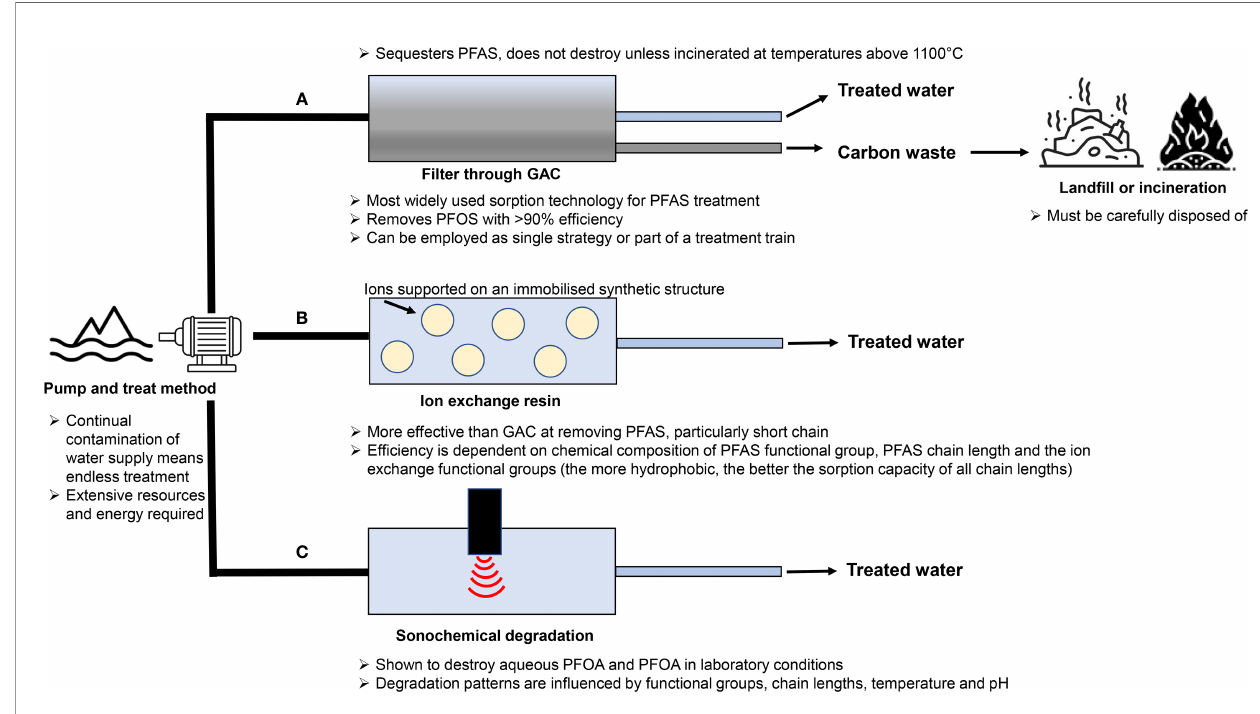
FIGURE 4 | Schematic diagram of three possible treatment mechanisms for PFAS contaminated water. (A) Carbon-rich sorbents such as granular activated carbon (GAC) have a long history of being utilised to remove a variety of organic contaminants from water and as such are by far the best studied and most widely used sorption technology for treating PFAS contaminated water sources (208). Granular activated carbon has been shown to reliably remove PFOS with over 90% ef fi ciency (59, 210) and is thus now the reference point for comparison of all new PFAS water sorption technologies. This technology can be employed to treat water before it reaches consumers, either as a single strategy, or as part of an integrated treatment programme. This treatment often involves the pump and treat method in which groundwater is extracted and fi ltered (208, 211), with the sorbent then being disposed of in land fi ll sites, provided certain risk criteria are met and the chemicals remain sequestered. International conventions state that waste materials containing > 50 mg/kg of PFAS must be treated in such a way as to destroy these chemicals, which is often accomplished by incinerating at high temperatures (over 1100°C) (208, 212). (B) Ion exchange uses anion exchange to target a wider range of PFAS, allowing for more ef fi cient removal. Removal occurs via electrostatic interactions between the charged functional groups of PFAS chemicals and ions supported on an immobilized synthetic structure (213). In comparison to activated carbon treatment, this method has been shown to be more effective in removing PFAS, particularly the short chain variants (205). However, the ef fi ciency of ion exchange technologies is dependent on several factors, such as the chemical composition of PFAS functional group, PFAS chain length and the ion exchange functional groups (the more hydrophobic, the better the sorption capacity of